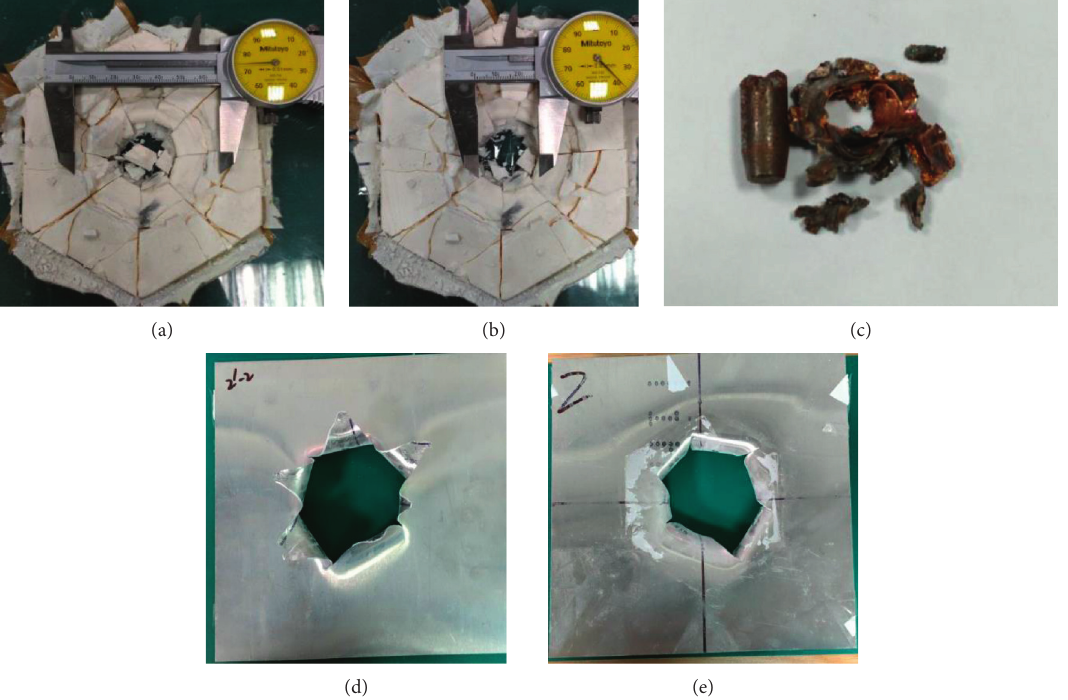
Figure 9: 10% 333 FGM + 1mm Al backplate. (a) The bottom of the ceramic conoid. (b) The top of the ceramic conoid. (c) Residual bullet. (d) The back of the aluminum backplate. (e) The front of the aluminum plate.